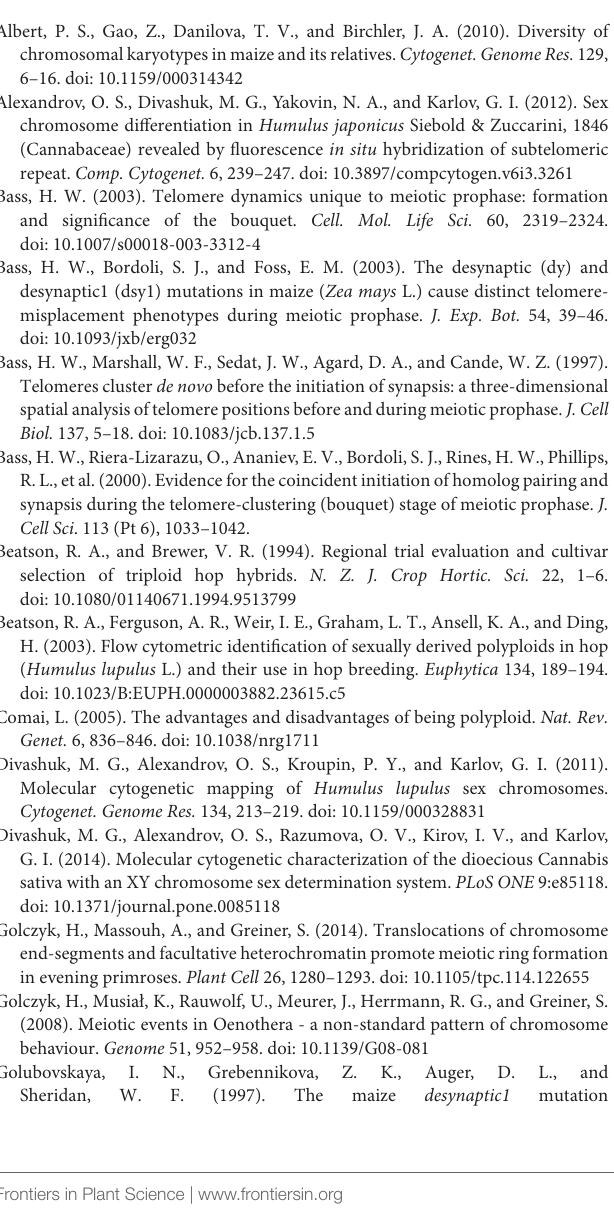
Figure 1 . Two nuclei from plant 255A at diplotene-diakinesis (A,D) show pairs (BB, dd) of 5S rDNA signals (green) and the lone, unpaired signal (L) in a whole-nucleus through-focus projection. Chromosomes (DAPI, red) bearing the lone signals were cropped out of the nucleus and shown from two angles (B,C,E,F) . The nucleus in panel D is also shown as spinning projections movie ( File S1 ). Figure S2 | FACS data for DNA content of selected hops. PE-A fluorescence intensity histograms for leaf-tissue nuclei are shown for plants from the pedigree shown in Figure 8 . Plants called with 2C DNA content (peaks around 58 PE-A, (A,B,C,E) or with 3C DNA content (peak around 80 PE-A, (D) are shown along with the names of the individual plants. File S1 | Spinning projection movie of 5S rDNA signals at late prophase from plant 255A. Quicktime movie showing maximum intensity projections of 3D dataset as that shown in Figure S1D